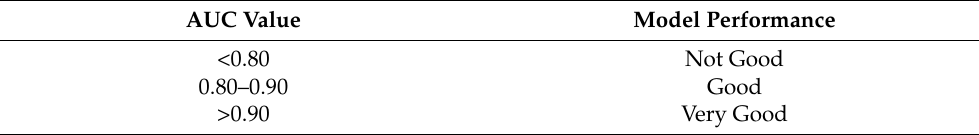
Table 1. The level of model accuracy based on the Area Under the Curve value.